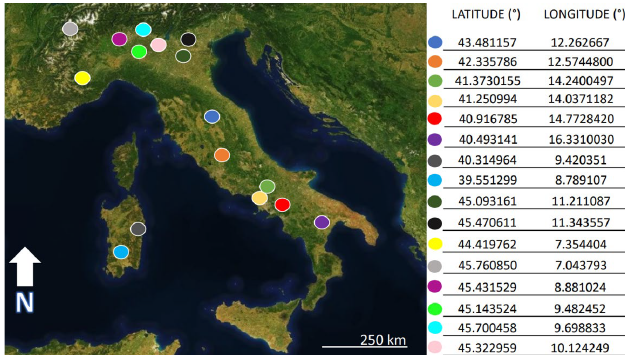
Fig. 3: Distribution of saffron producers participating in this experiment. Some farms participated to more than one experimental